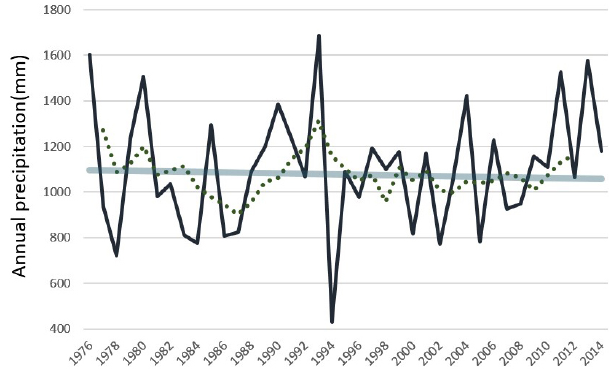
Figure 6. Annual variations and trend of 5 year average precipita- tion from